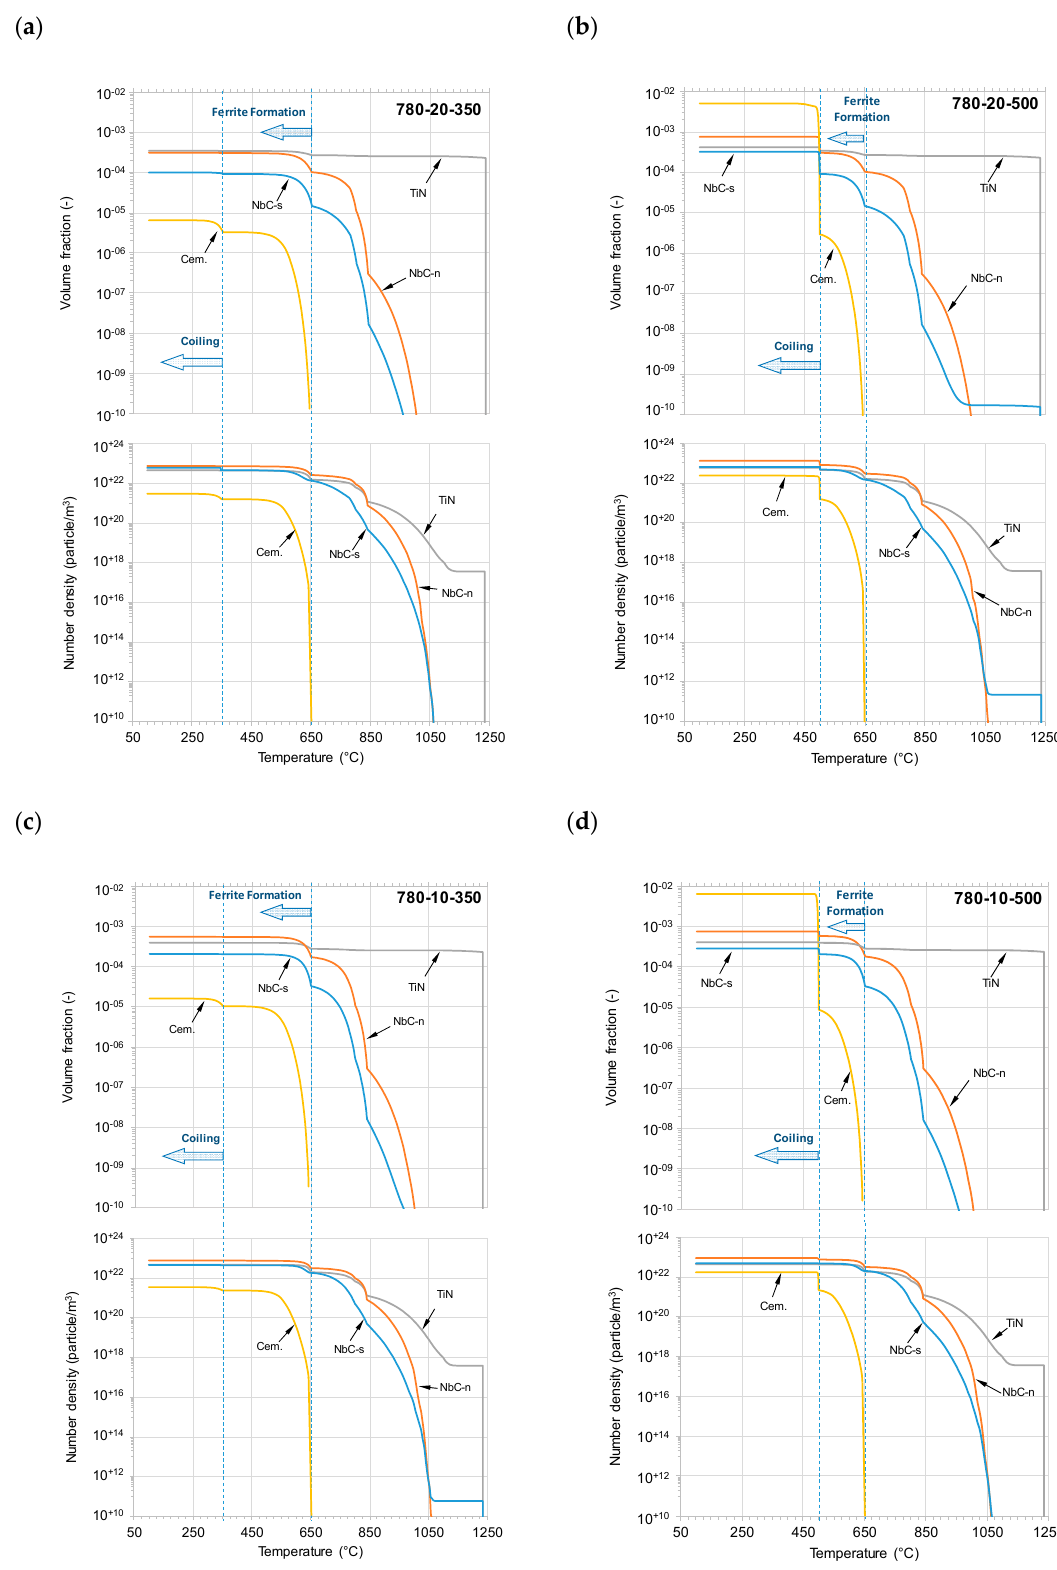
Figure 11. Predicted precipitation development for steels having FRT = 780 °C using the software MatCalc ® and applying the parameters ( a ) 20 K·s − 1 -350 °C, ( b ) 20 K·s − 1 -500 °C, ( c ) 10 K·s − 1 -350 °C and ( d ) 10 K·s − 1 -500 °C.